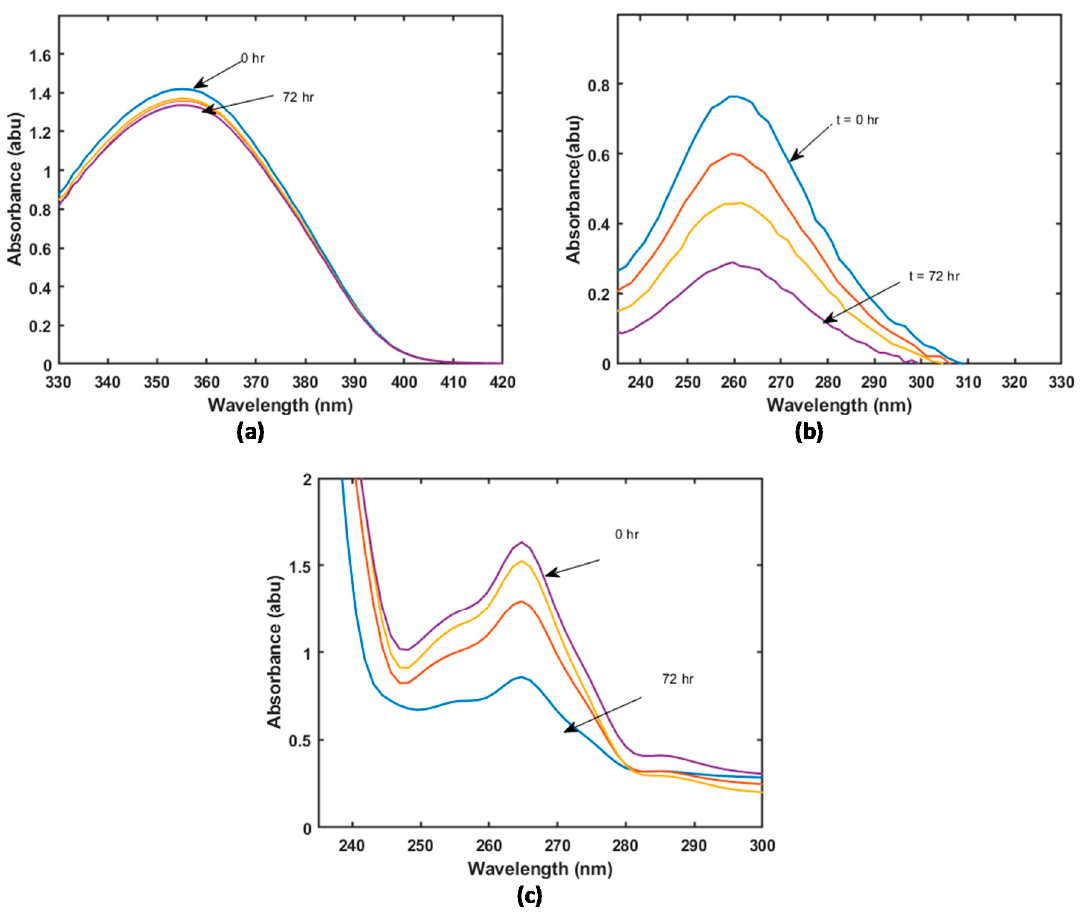
Figure 4. UV spectra of solution samples containing BCS Class II drugs taken at different times during loading of Ibuprofen onto HKUST-1. The initial concentration of the solution before loading MOF material was 1 g/L. ( a ) Felodipine ( b ) ketoprofen ( c ) Ibuprofen.